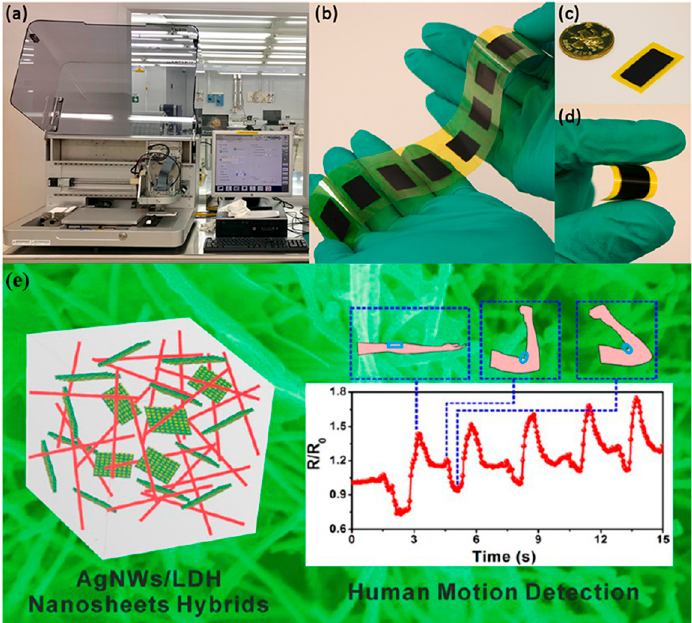
Figure 21. The printer ( a ) and ( b – d ) an inkjet-printed on Kapton piezoresistive dynamic strain sensor based on carbon black and polyvinyl pyrrolidone; (reproduced with permission from [77], copyright 2019, Elsevier); ( e ) an AgNW/LDH composite sensor for detection of different movements on human arm (reproduced with permission from [78] copyright 2015, American Chemical Society).